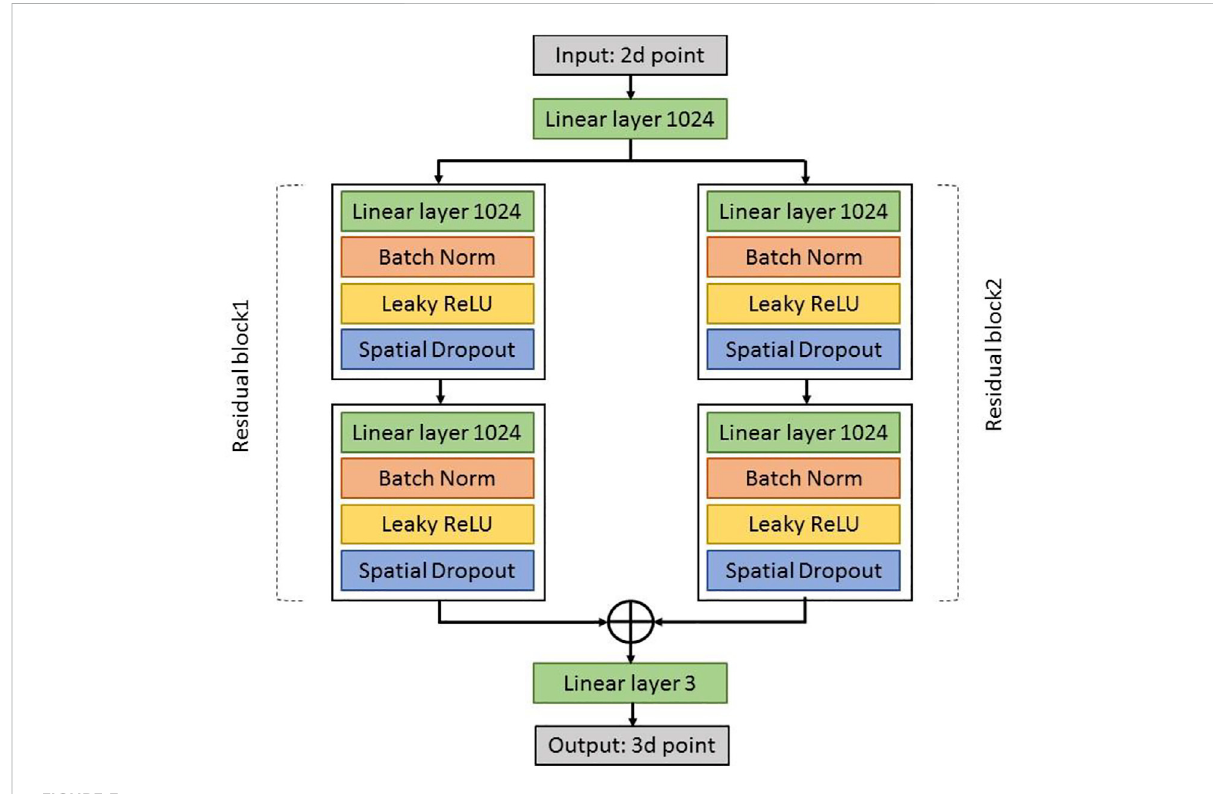
FIGURE 3 Diagram with the basic building blocks of